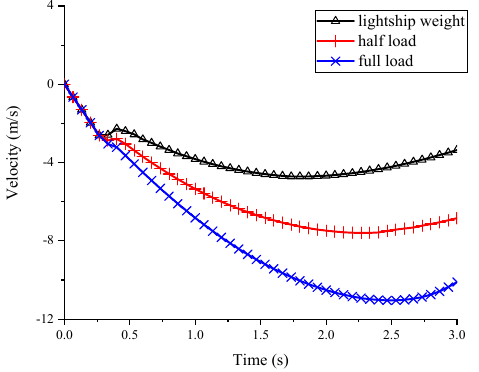
Figure 15. Comparison of the velocity of the parallel middle body among three loading conditions.